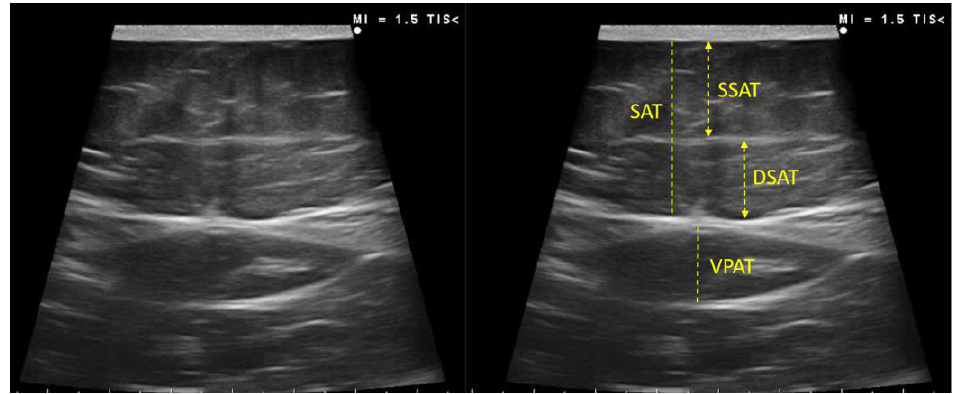
Figure 3. Measurement of subcutaneous and visceral preperitoneal adipose tissue at the abdominal level by ultrasound of a participant of our sample. SSAT — superficial subcutaneous adipose tissue; DSAT — deep subcutaneous adipose tissue; VPAT — visceral preperitoneal adipose